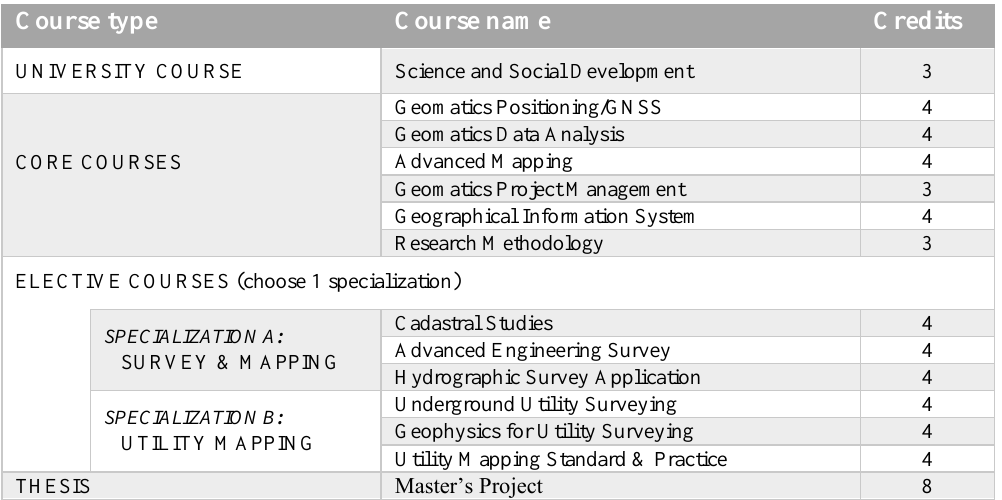
Table 3. Curriculum of M.Sc. in Geomatic (by course work) at UTM FGHT.